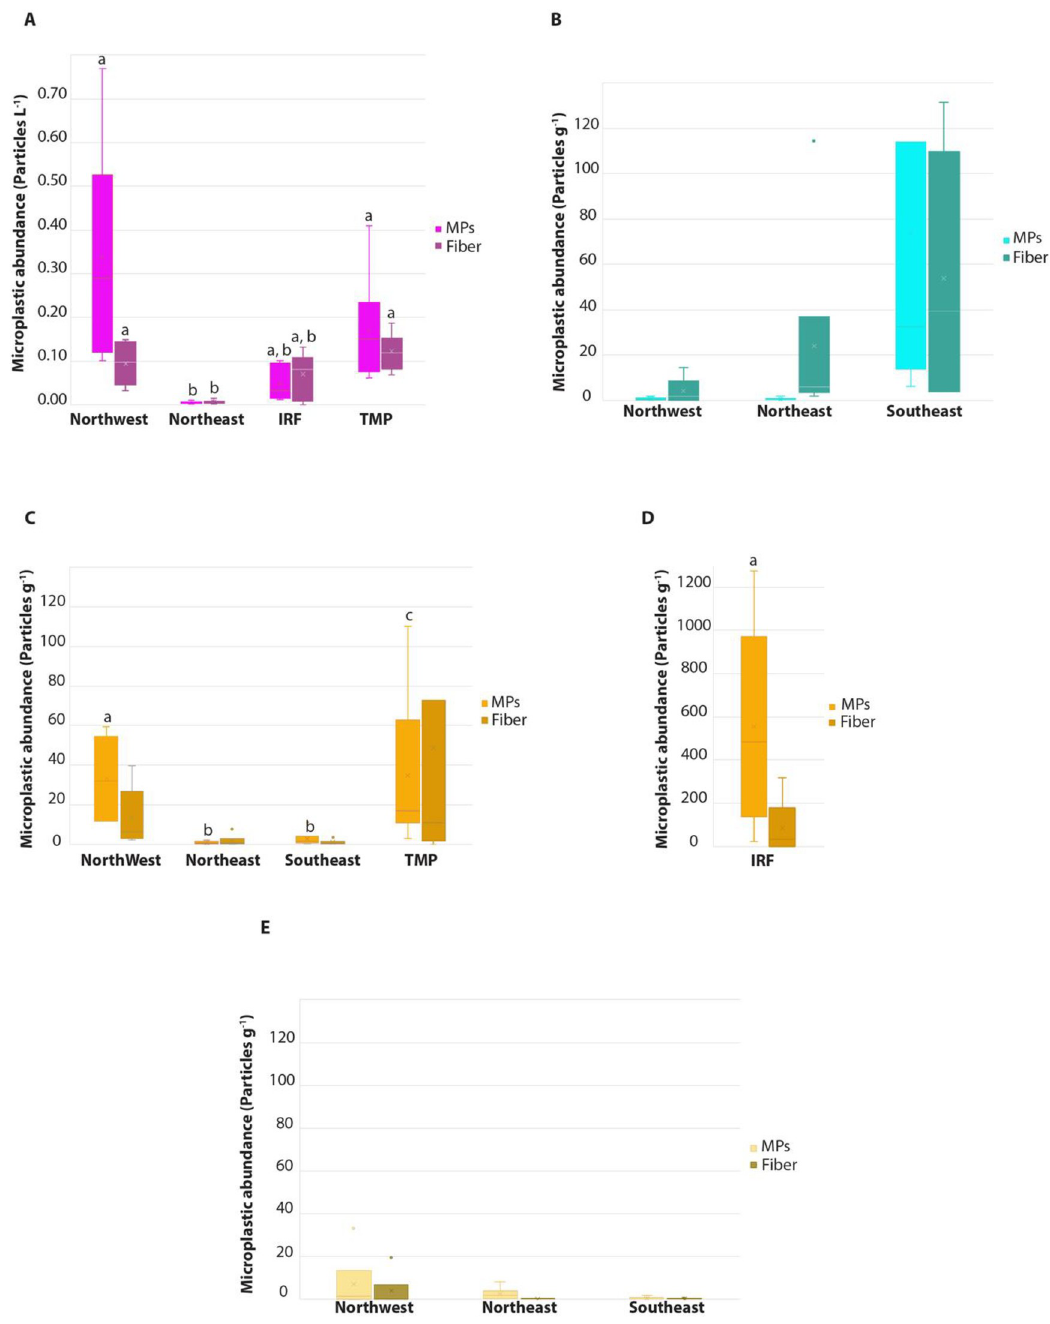
Fig 2. Microplastic abundance from the 5 different sites investigated, Northwest, Northeast, Inner Reef (IRF), wastewater treatment plant (TMP). A: surface seawater, B: sediments from the outer barrier reef, C & D: sediments from the inner barrier reef, E: Beaches. Light colors: plastic particles between 100 microns and 5 mm, Dark colors: plastic fibers. Median values are represented with a line in the boxplots, the average with a cross and outliers with dots. Different letters above the columns indicate significant differences between sites for MP-fragments and fibers separately (one way ANOVA followed by Tukey’s HSD test): p < 0.05.